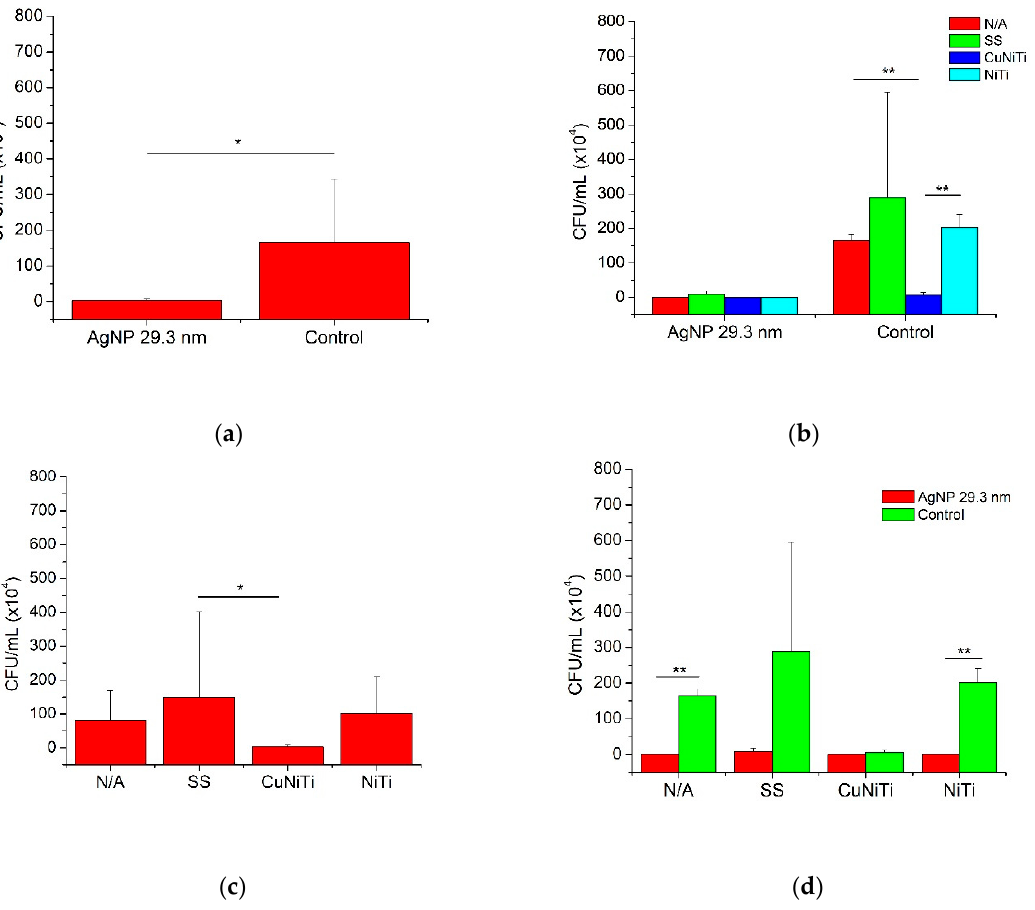
Figure 2. The anti-adherence activity of AgNP according to the orthodontic wire. AgNP = silver nanoparticles; N/A = no archwire; SS = stainless steel; CuNiTi = copper/nickel/titanium; and NiTi= nickel/titanium. Statistical comparisons between groups (AgNP and distilled water) and subgroups (orthodontic wires and S. mutans serotypes) were analyzed by Mann – Whitney U test for non ‐ parametric values. Statistical differences were presented using asterisks (* = p < 0.05 ; ** = p < 0.01).